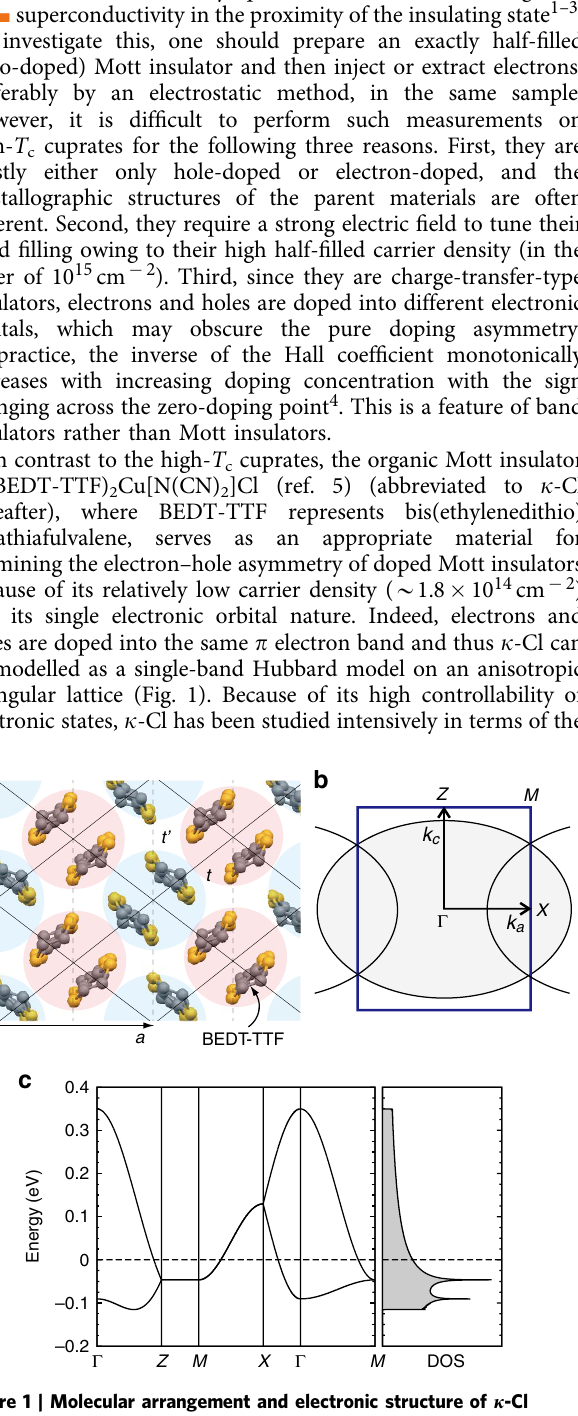
Figure 1 | Molecular arrangement and electronic structure of j -Cl without electron correlation. ( a ) Molecular arrangement of the BEDT-TTF layer and the effective anisotropic triangular lattice. t is the nearest-neighbour hopping (solid line) and t ’ is the next-nearest-neighbour hopping (dashed line) between the BEDT-TTF dimers. Two differently oriented dimers are indicated by red and blue shades. ( b ) Schematic representation of Fermi surface without electron interaction. The first BZ of k -Cl is indicated by a solid square. ( c ) Tight-binding band structure and DOS for t ’/ t ¼ (cid:2) 0.8 with t ¼ 55meV. Here, G ¼ (0,0), Z ¼ (0, p / c ), M ¼ ( p / a , p / c ) and X ¼ ( p / a ,0). The Fermi energy is denoted by dashed lines. DOS, density of